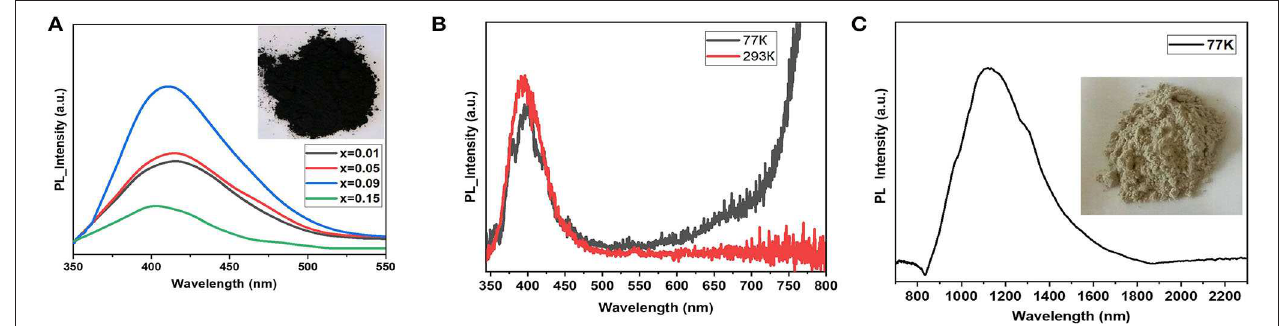
Figure 4A shows photoluminescence spectra of the